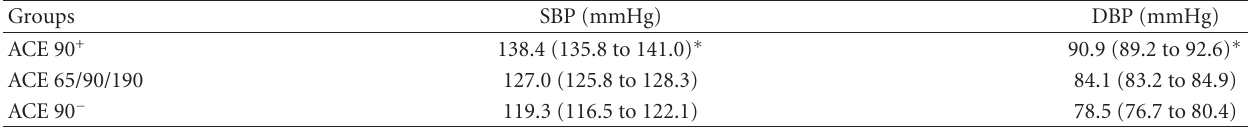
Table 4: Systolic and diastolic blood pressure levels and ACE isoforms in adjusted covariance analysis. Groups